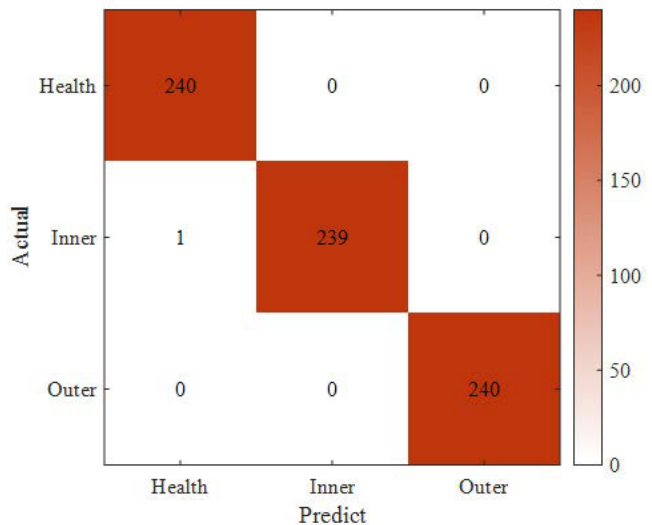
Figure 8. RTFANet model confusion matrix on test